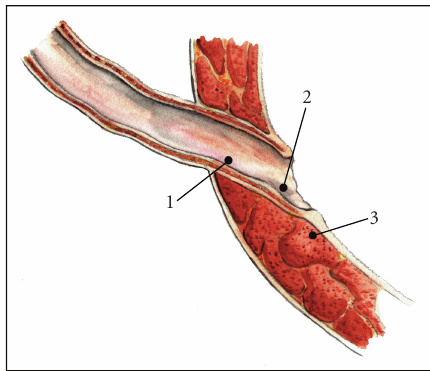
Figure 2: Needle placement algorithm for the endoscopic treatment of VUR. Sites 1 and 2 comprise the double-HIT method, while site 3 (STING) is rarely